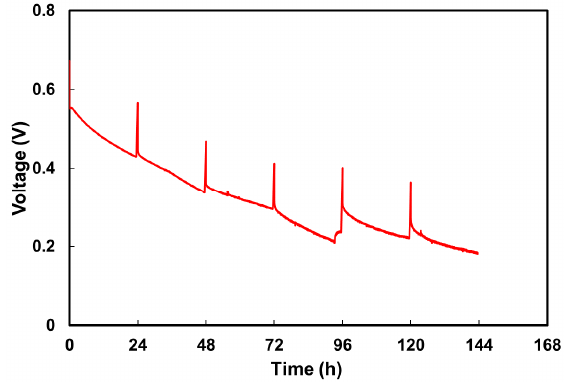
Figure 10. Long-term DMAFC voltage of PVA/40.5% ZIF-8 membrane at 60 °C at current density of 50 mA cm − 2 using catalyst of 2 mg cm − 2 Pt–Ru on carbon cloths and 1 mg cm − 2 Pt on carbon cloths with micro-porous layer (MPL) for anode and cathode respectively (2 M methanol with 6 M KOH at a flow rate of 5 mL min − 1 for anode fuel and humidified oxygen at a flow rate of 100 mL min − 1 for cathode feed). The anode fuel was replenished after 93 h.